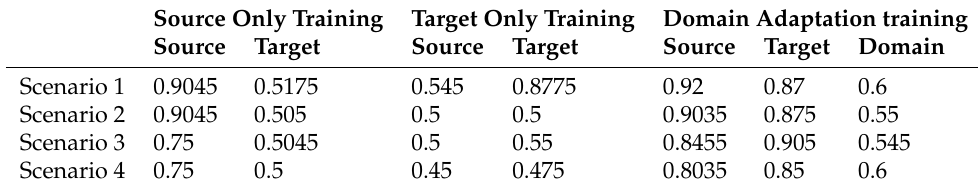
Table 4. Training accuracy results of